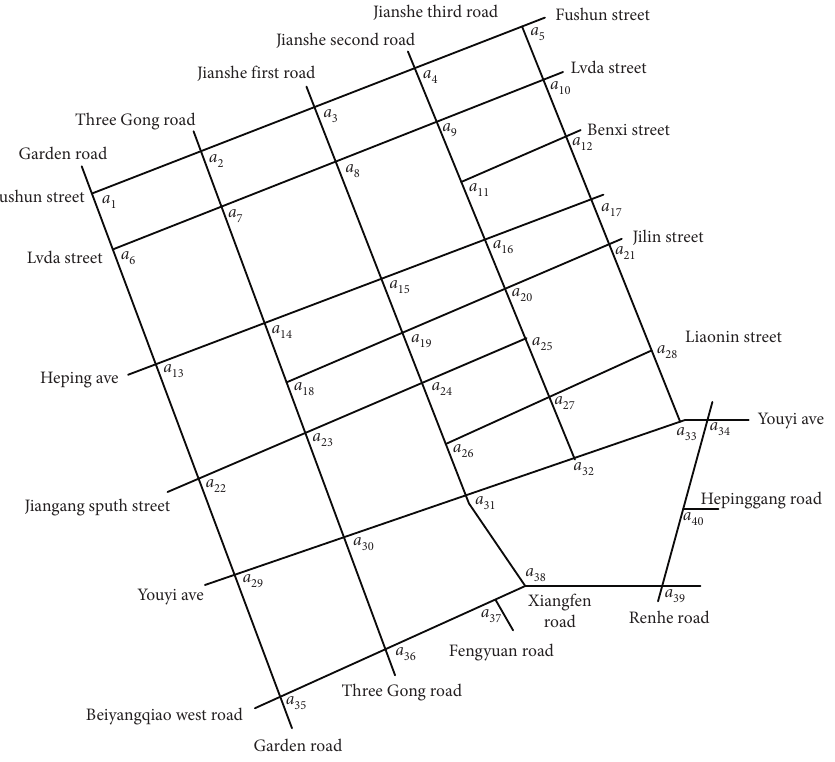
Figure 4: Model validation of road network. Note: a stands for intersection. Table 1: Preliminary partition results.